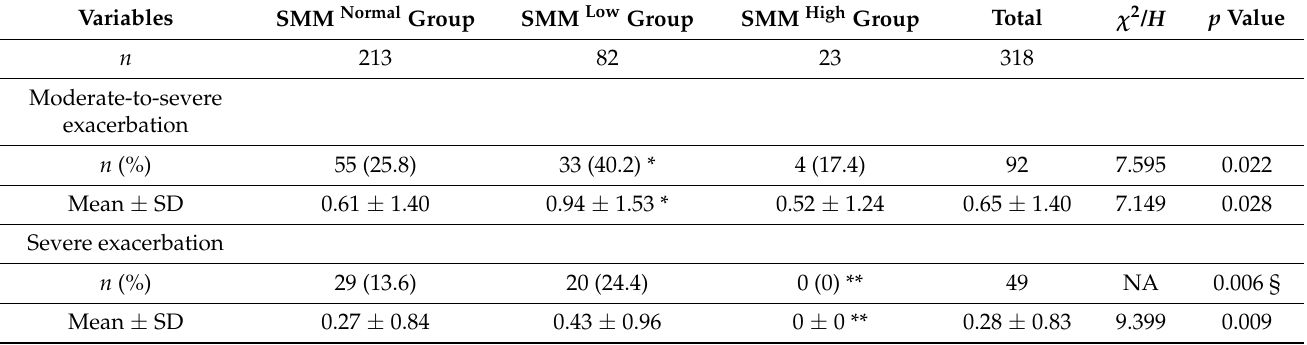
Table 3. Asthma exacerbation within the 12-month follow-up period grouped by SMM in the training